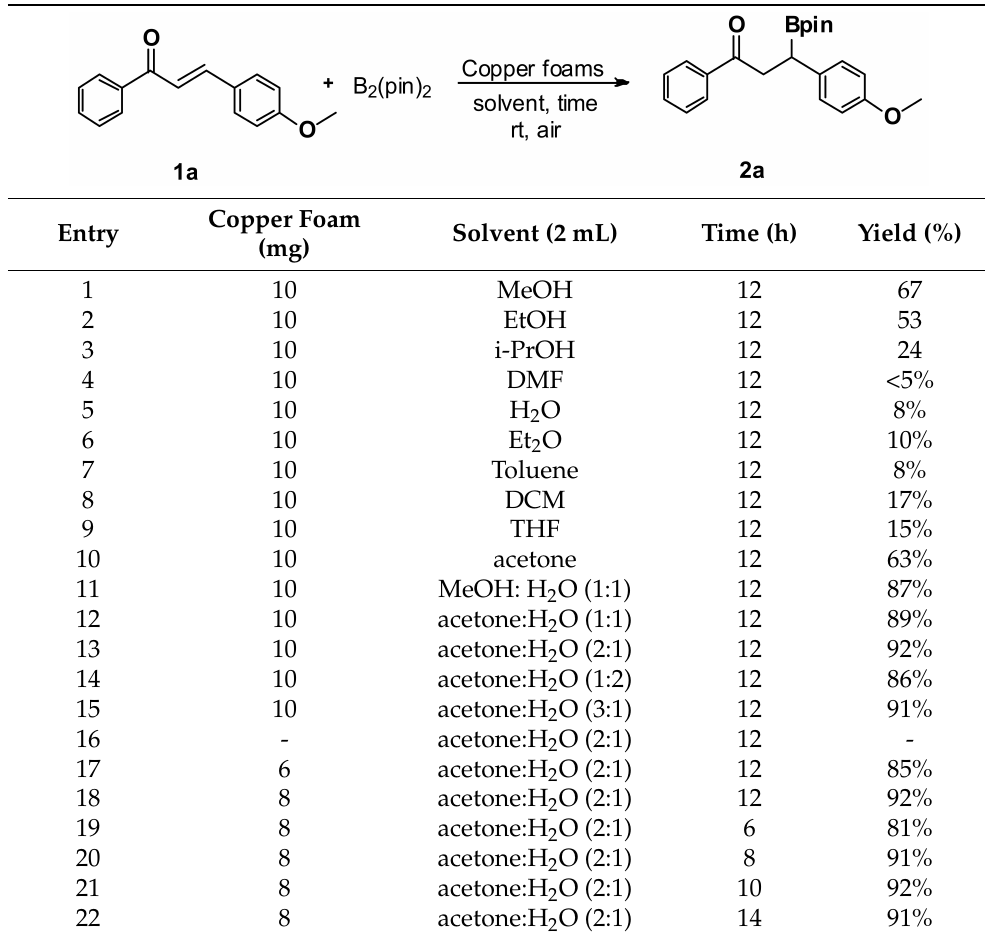
Table 1. Optimization of reaction